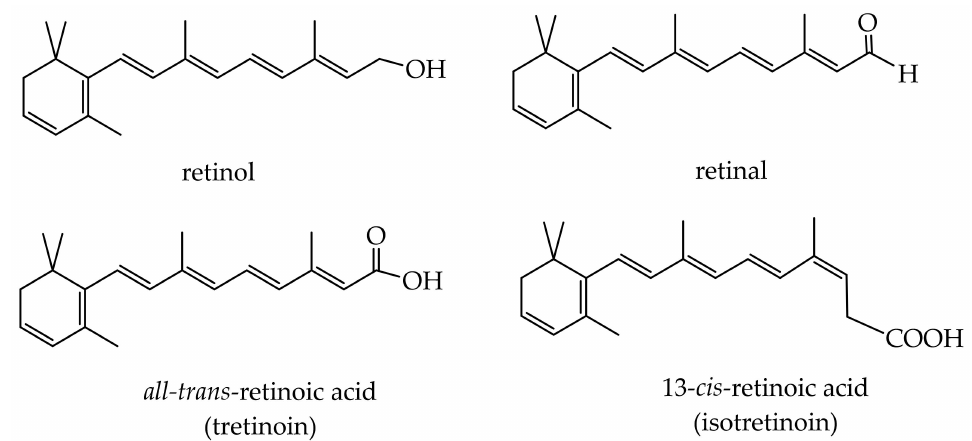
Figure 2. Structures of the most widespread